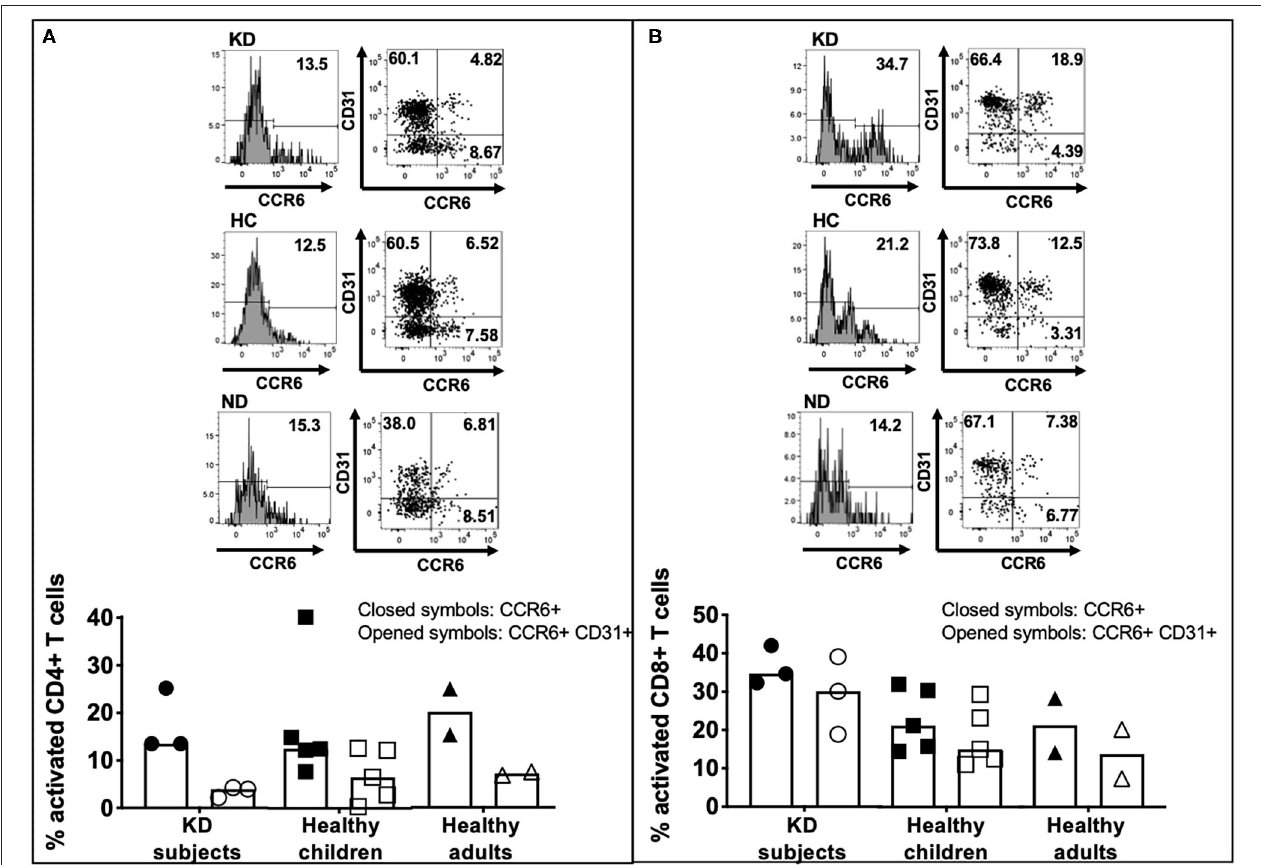
FIGURE 5 | CCR6 and CD31 expression on activated LCWE-specific CD4 + and CD8 + T cells. To address the ability of LCWE-specific CD4 + and CD8 + T cells to home to the vessels (CCR6) and their potential role in the pathogenesis of vascular inflammation, the expression of CCR6 and CD31 on activated LCWE-specific T cells was studied. PBMC from subacute KD subjects ( n = 3; KD 5–7, Table 1 ), healthy children ( n = 5; HC 5–9, Table 1 ), and healthy adults ( n = 2; ND3–4, Table 1 ) were stimulated with LCWE (1 µ g/ml) for 4 days and the expression of CCR6 and CD31 on CD4 + HLA-DR + (A) and CD8 + HLA-DR + (B) T cells were studied by flow cytometry. A representative FACS plot of CCR6 + and CCR6 + CD31 + T cells from each cohort is shown. Activated CD4 + T cells showed a higher prevalence of CCR6 + CD31- (4.85–32.3%) than CCR6 + CD31 + (0.36–12.6%) suggesting that if these cells homed to the vessels, they could promote inflammation. Activated CD8 + T cells showed higher expression of CD31 + within the CCR6 + T cells than CD4 + T cells (7.38–39.1%) vs. CD31- (2.87–8.87%). The data are shown as scatter dot plots with median and interquartile range. Each symbol represents the results derived from each subject tested. Closed symbols: percent activated CD4 + or CD8 + T cells express CCR6. Opened symbols: percent activated CD4 + or CD8 + T cells express both CCR6 and CD31. The statistical differences between cohorts were tested by one-way ANOVA. A P < 0.05 was considered significant. No difference of CCR6 + and CCR6 + CD31 + expression on CD4 + (CCR6 + , p = 0.9489; CCR6 + CD31 + , p = 0.5132) and CD8 + (CCR6 + , p = 0.2563; CCR6 + CD31 + , p = 0.1678) T cells were found among the 3